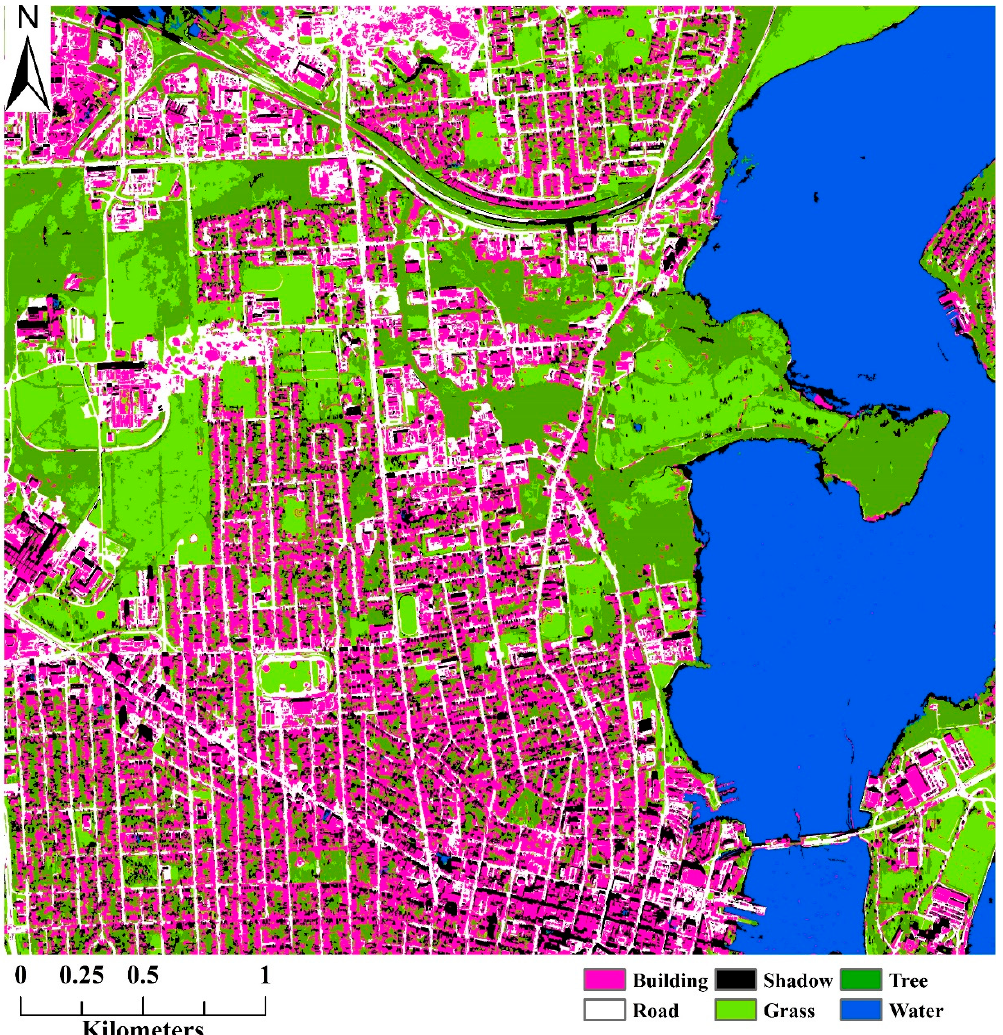
Figure A13. Classification map generated by combining classification maps of the MLP model for the 50 cm image.